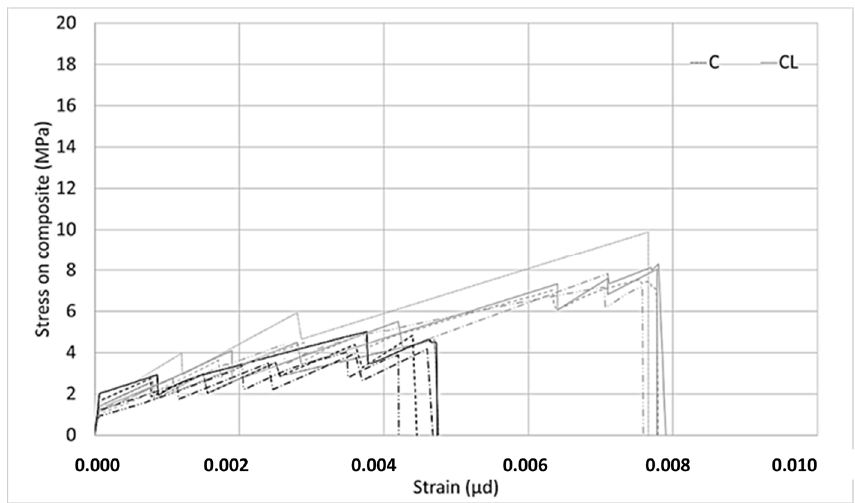
Materials 2020 , 13 , x Figure 11. Stress on the composite–strain relationship of the M120 composite. Figure 11. Stress on the composite–strain relationship of the M120 composite.